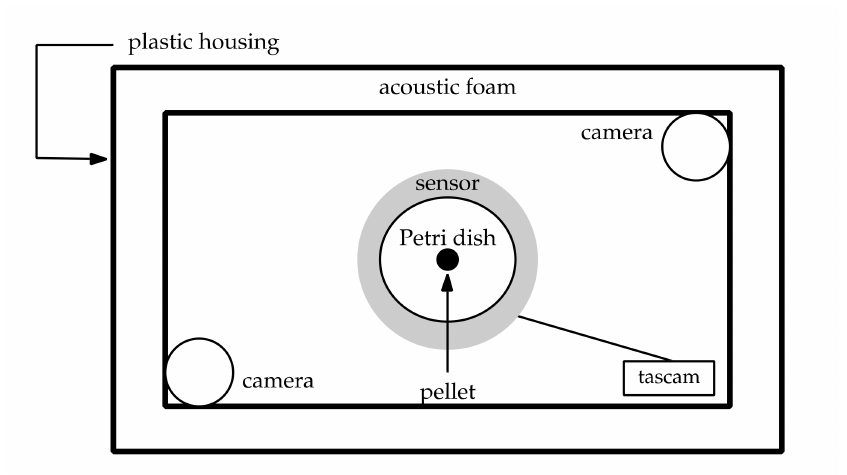
Figure 1. Audio and video equipment used to record bioacoustics laboratory trial experiments, not to